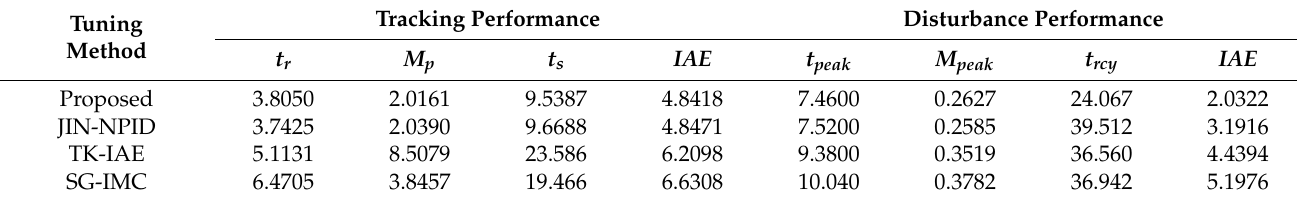
Figure 7. Servo and regulatory responses for nominal process 1. Table 2. Quantitative comparison of performances for nominal process